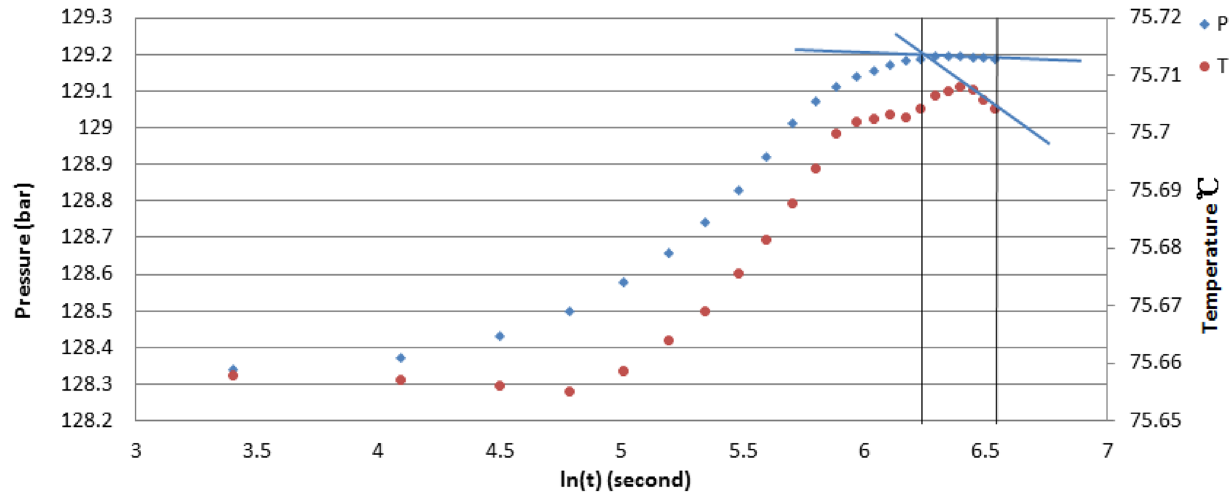
Fig.19 TTA of transient IV: ε ′ = dT / dP = 0.01/0.018 = 0.556 C/bar